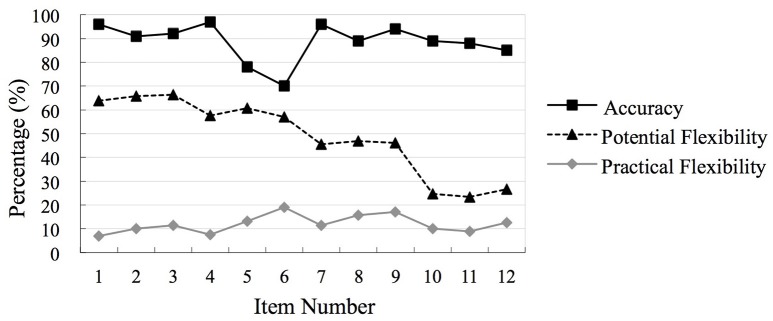
Distribution scoring percentage of accuracy. Practical flexibility and practical flexibility on each item (N = 158).